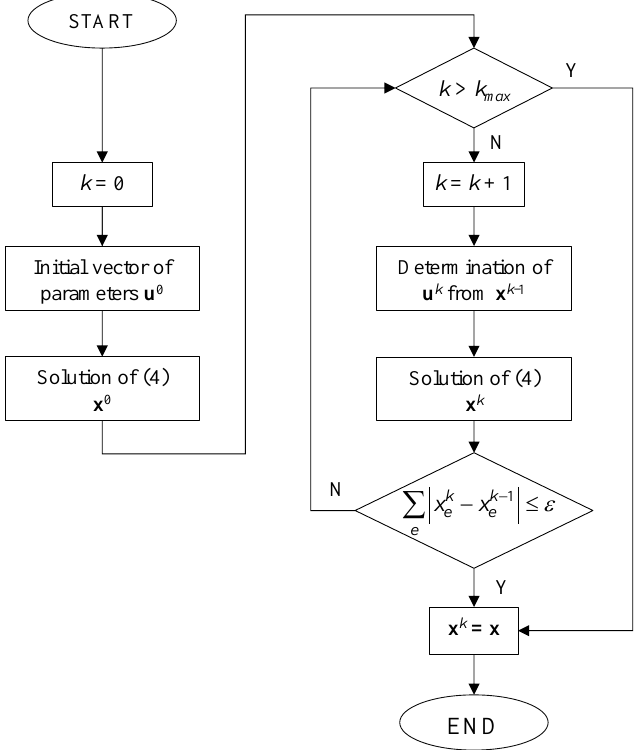
Figure 1. Flowchart of the iterative methodology to account for non-linear parameters in the mixed integer linear programming (MILP) algorithm.